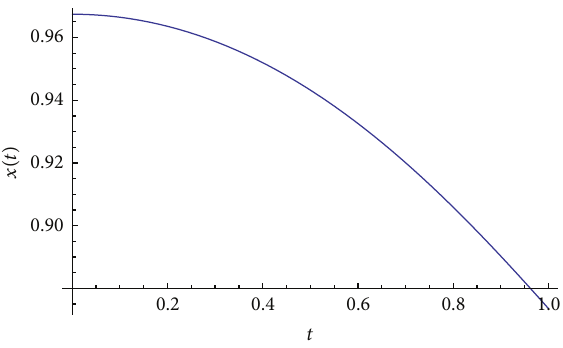
Figure 1: Absolute errors of Example 1. For different values of iteration 𝑛 .